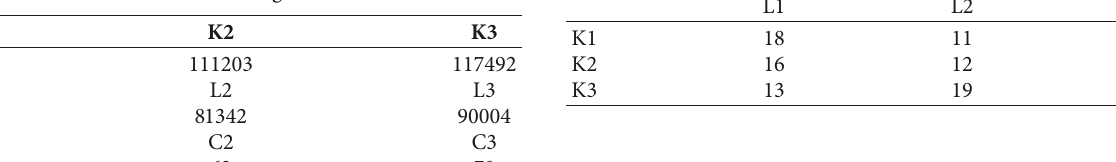
Table 4: Fixed cost of building a reliable and unreliable distribution center and maintenance cost of relief goods.